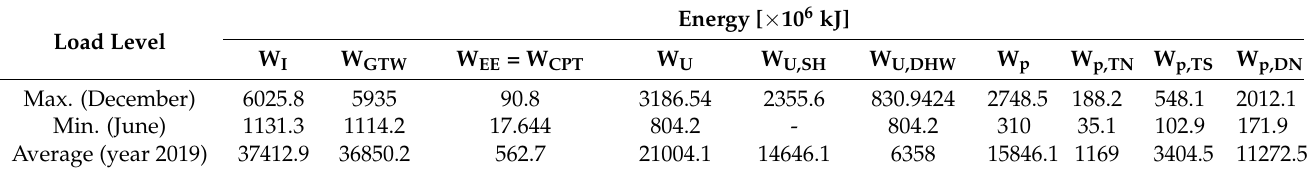
Figure 11. Energy flow diagram of the real hourly CEB, 20–22 January 2020. Table 12. Results of the real CEB, for maximum load, minimum load, and average [(overall year